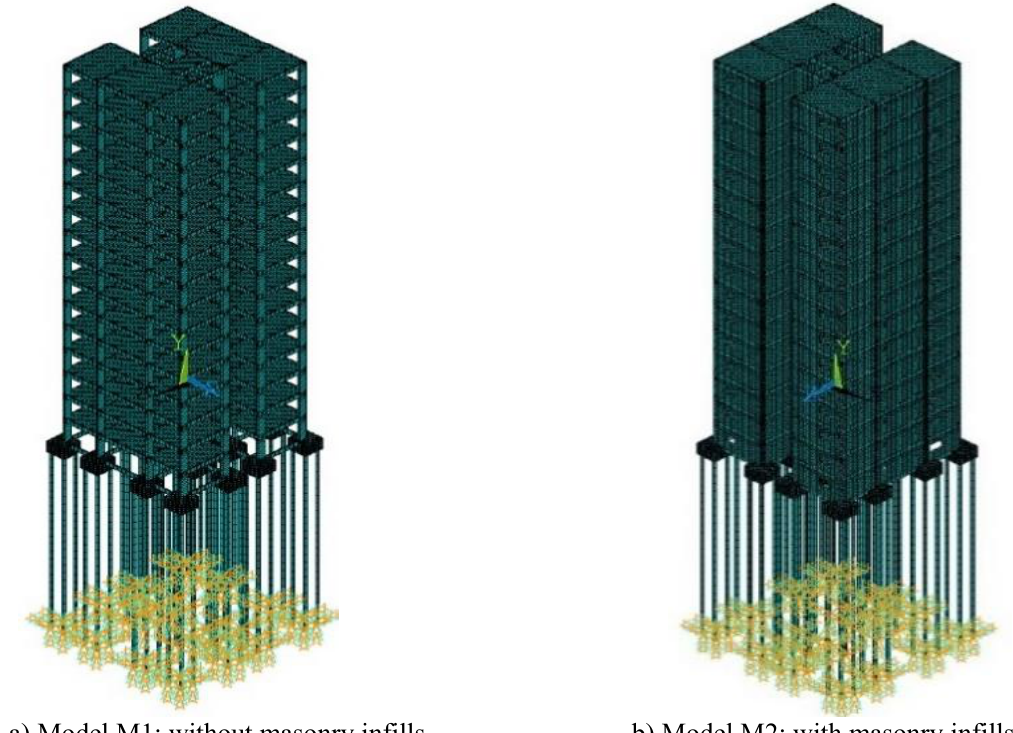
Fig. 4. Finite element model of the investigated reinforced concrete building: M1 e M2.